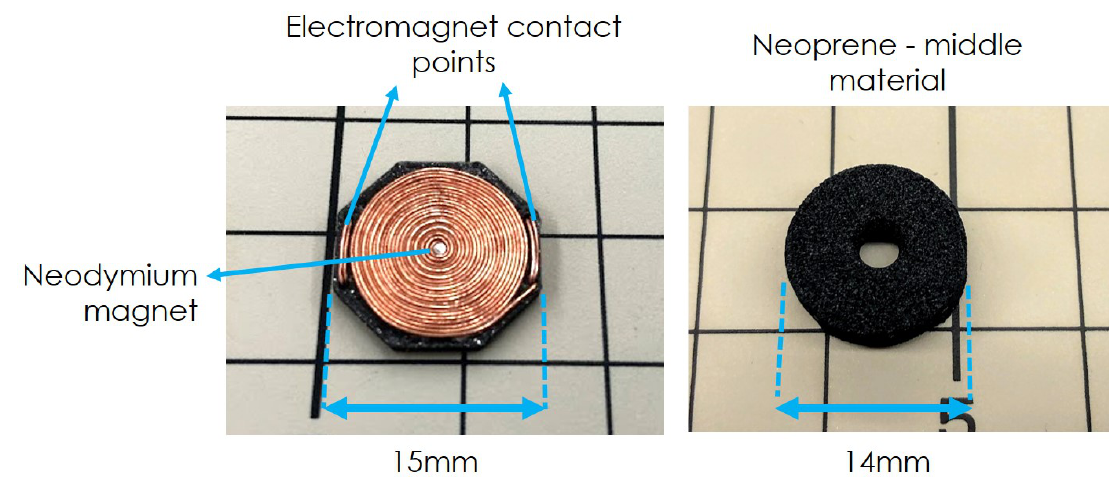
Figure 2. Left: New coil. Manually wound, using enameled copper wire 0.26 mm in diameter. A small neodymium magnet is pasted in the center of the coil. Right: neoprene disc of 14 mm of diameter with a hole in the